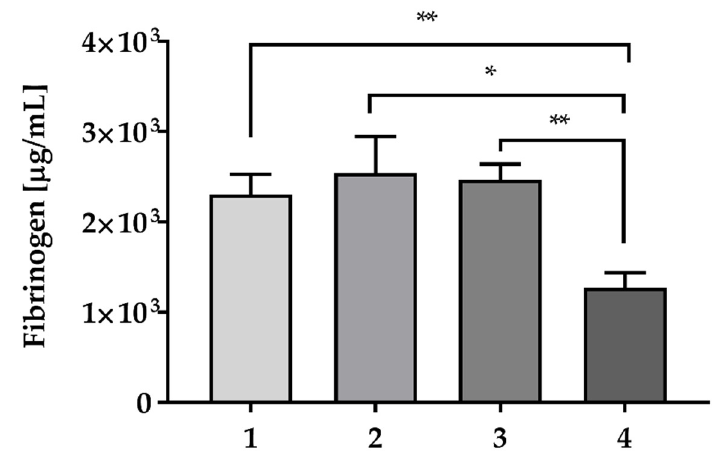
Figure 1. Fibrinogen concentration ( µ g/mL) in the PRP samples. Data are expressed as means ± SD, analysis was performed in triplicate. (* p < 0.05, ** p < 0.01).